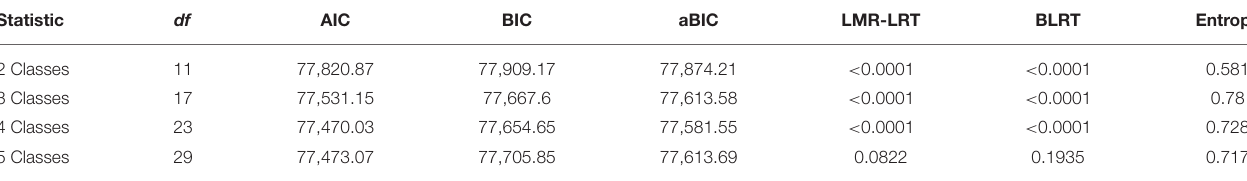
TABLE 2 | Model fit statistics for each of the fitted latent class analysis (LCA)